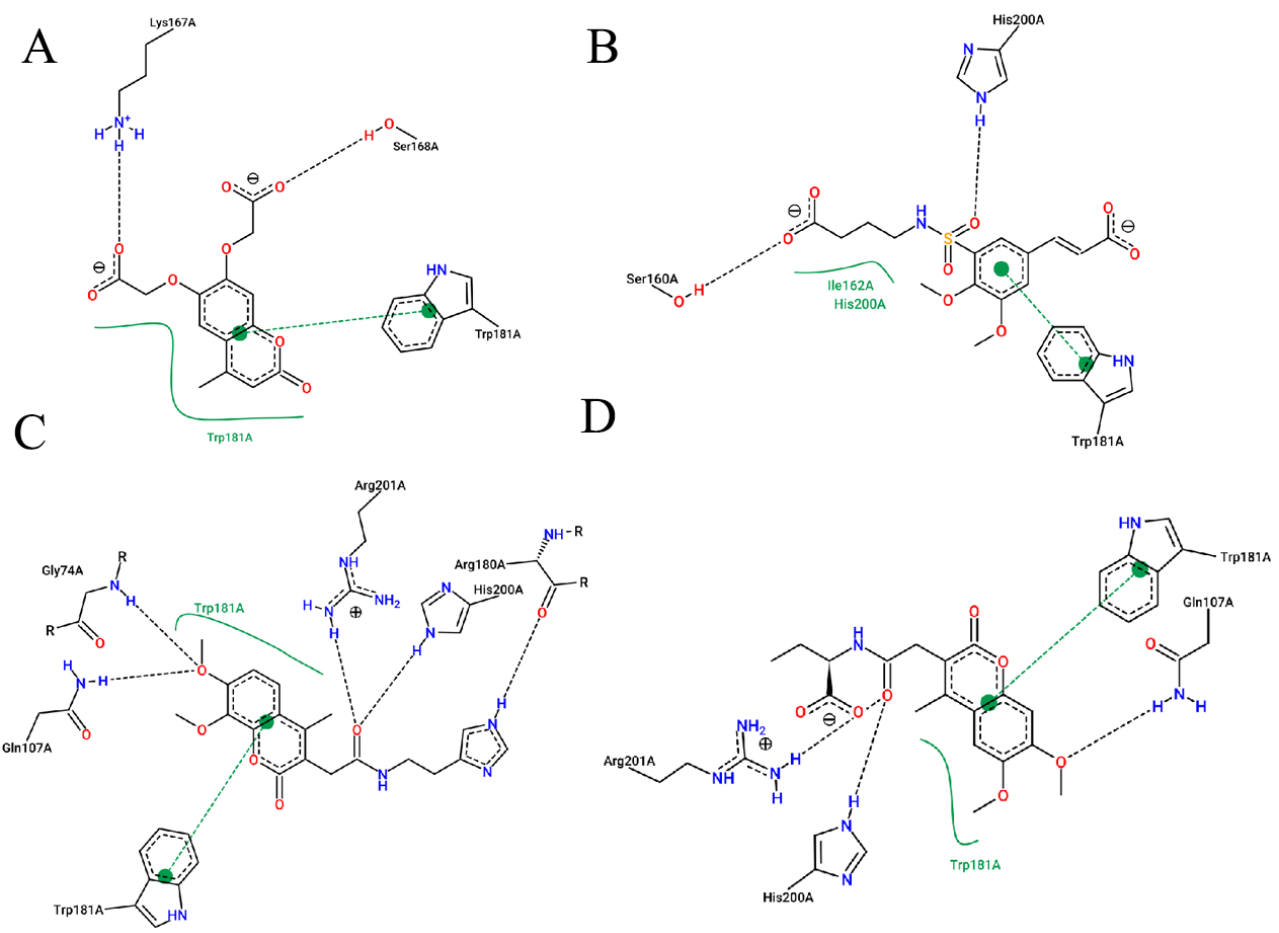
Figure 3. A floor plan view of the docking results, including ( A ) S-11593, ( B ) S-25207, ( C ) S-69904, and ( D ) S-52372.